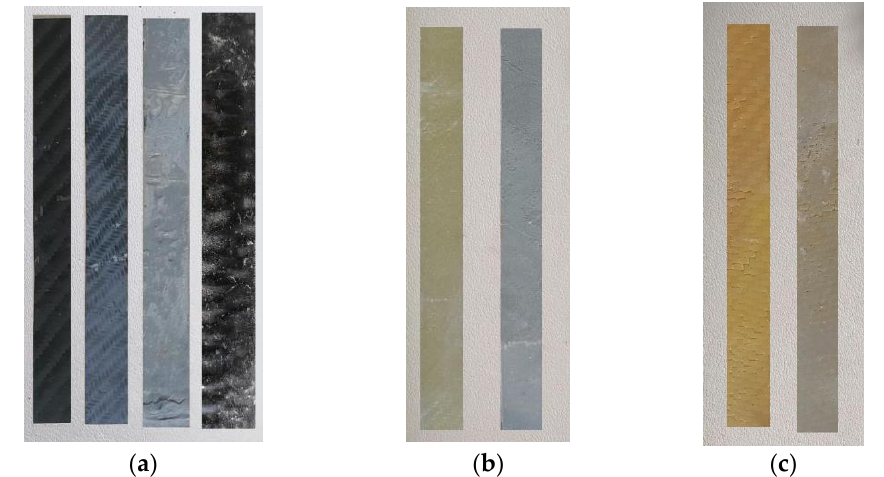
Table 1. Composite materials of epoxy resin–carbon fiber and cement specimens.